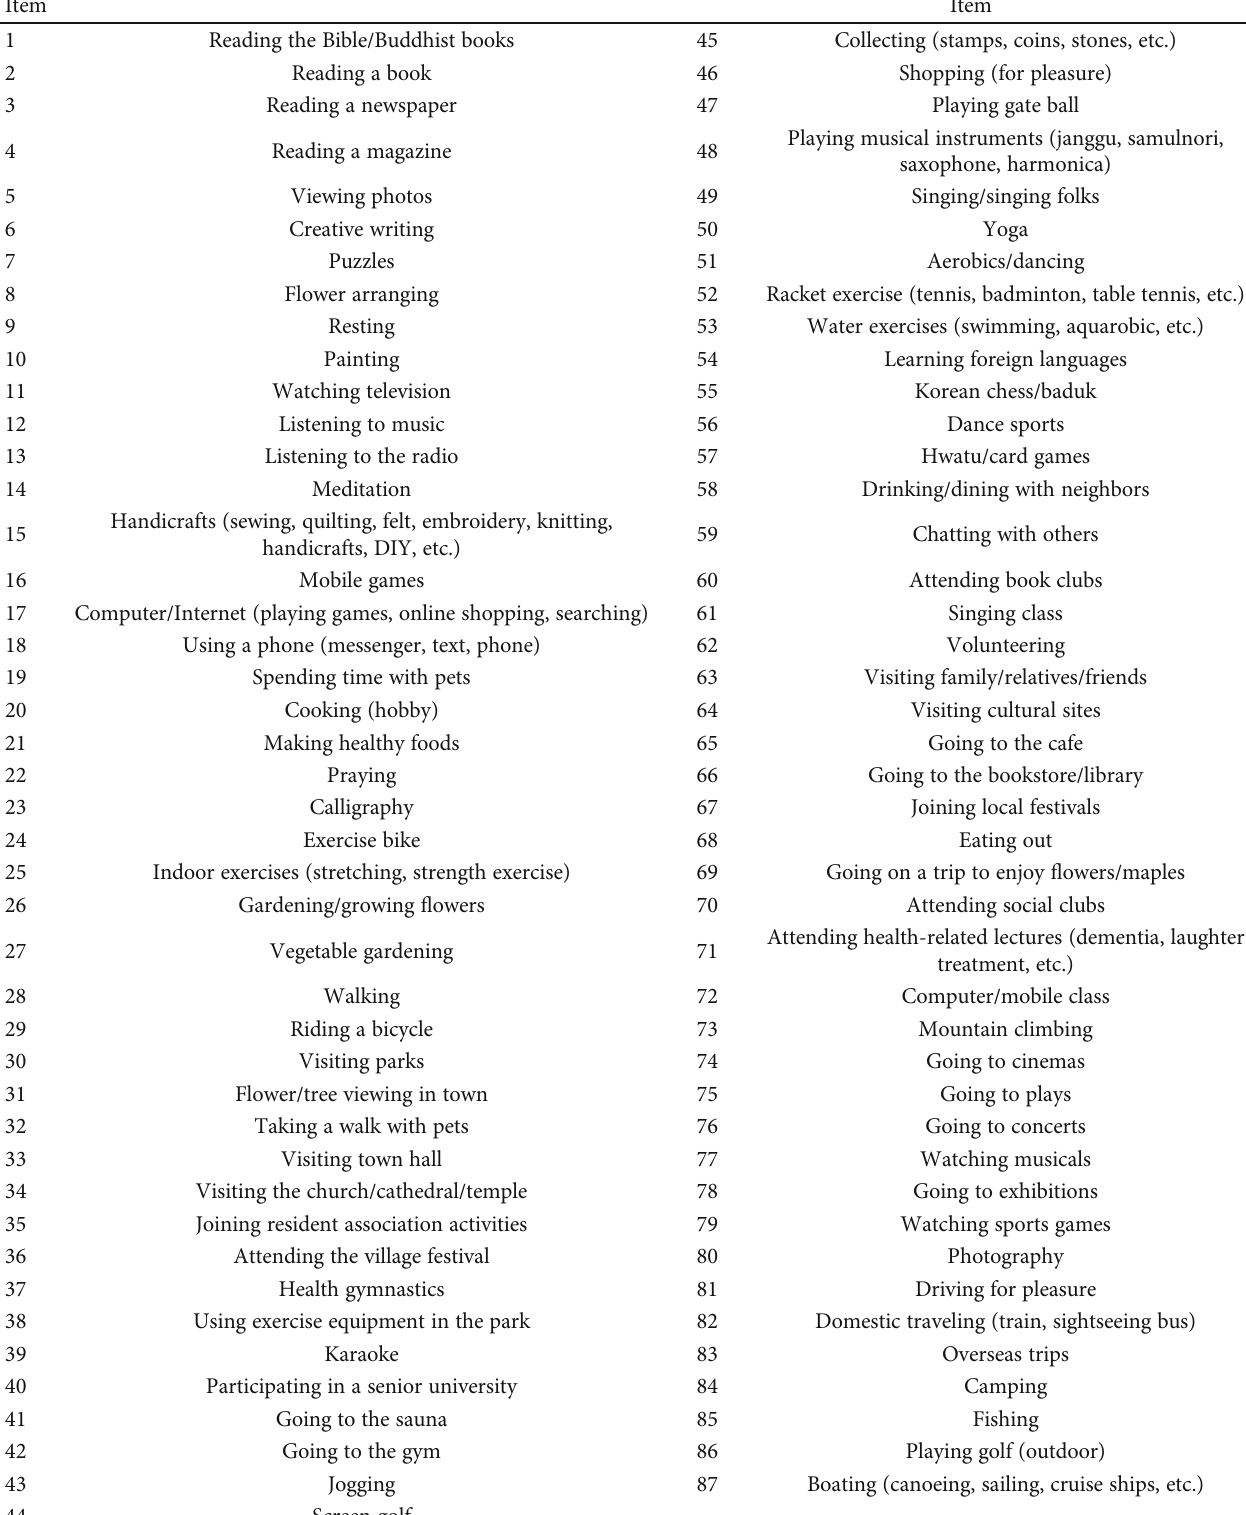
Table 2: The fi nal item of the leisure participation assessment for the elderly through the Delphi